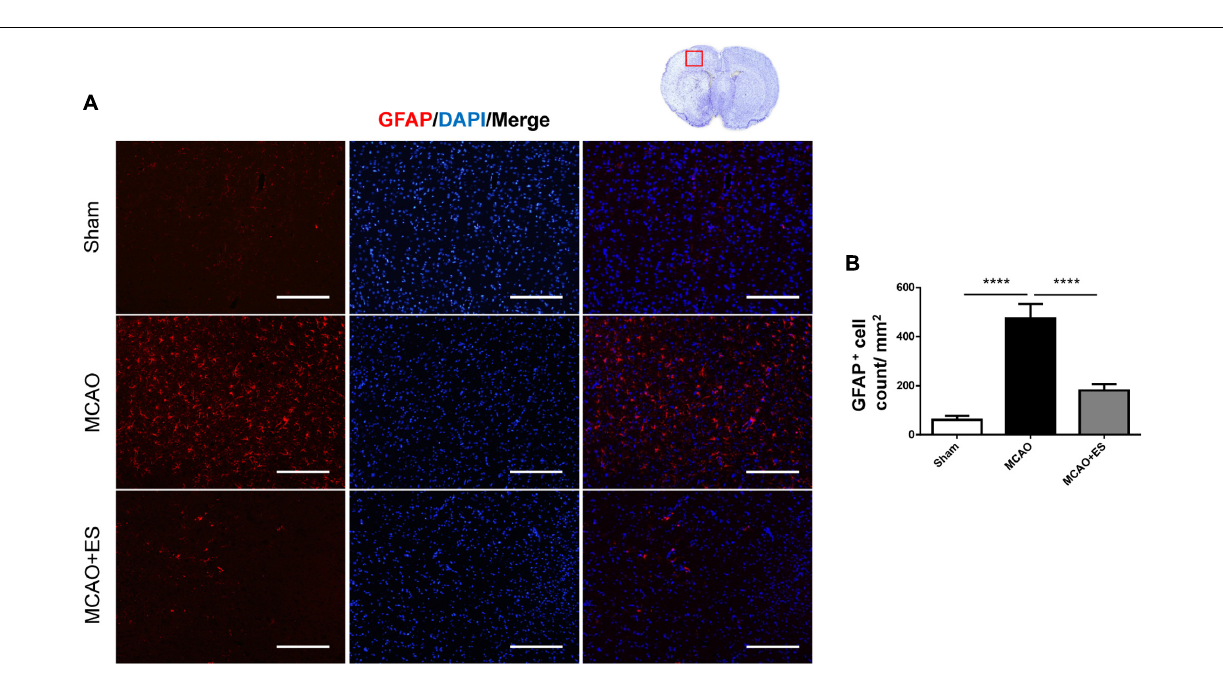
Frontiers in Aging Neuroscience |